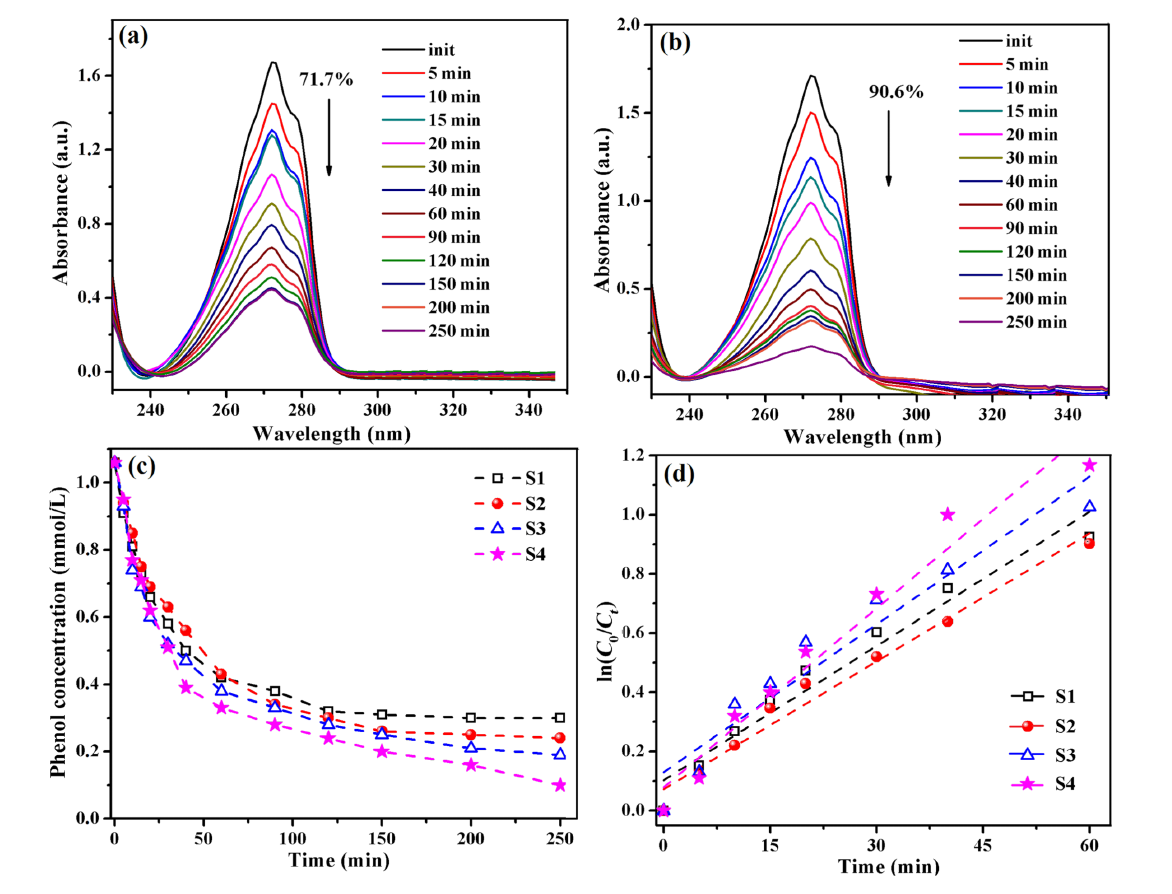
Figure 6: Changes of UV–vis absorption spectra of an aqueous phenol solution in the presence of S1 (a) and S4 (b) films used as catalysts moni- tored as a function of UV irradiation time; temporal evolution of the phenol concentration (c) and fitted curves for the kinetic estimation of phenol pho- todegradation (d) in presence of S1–S4